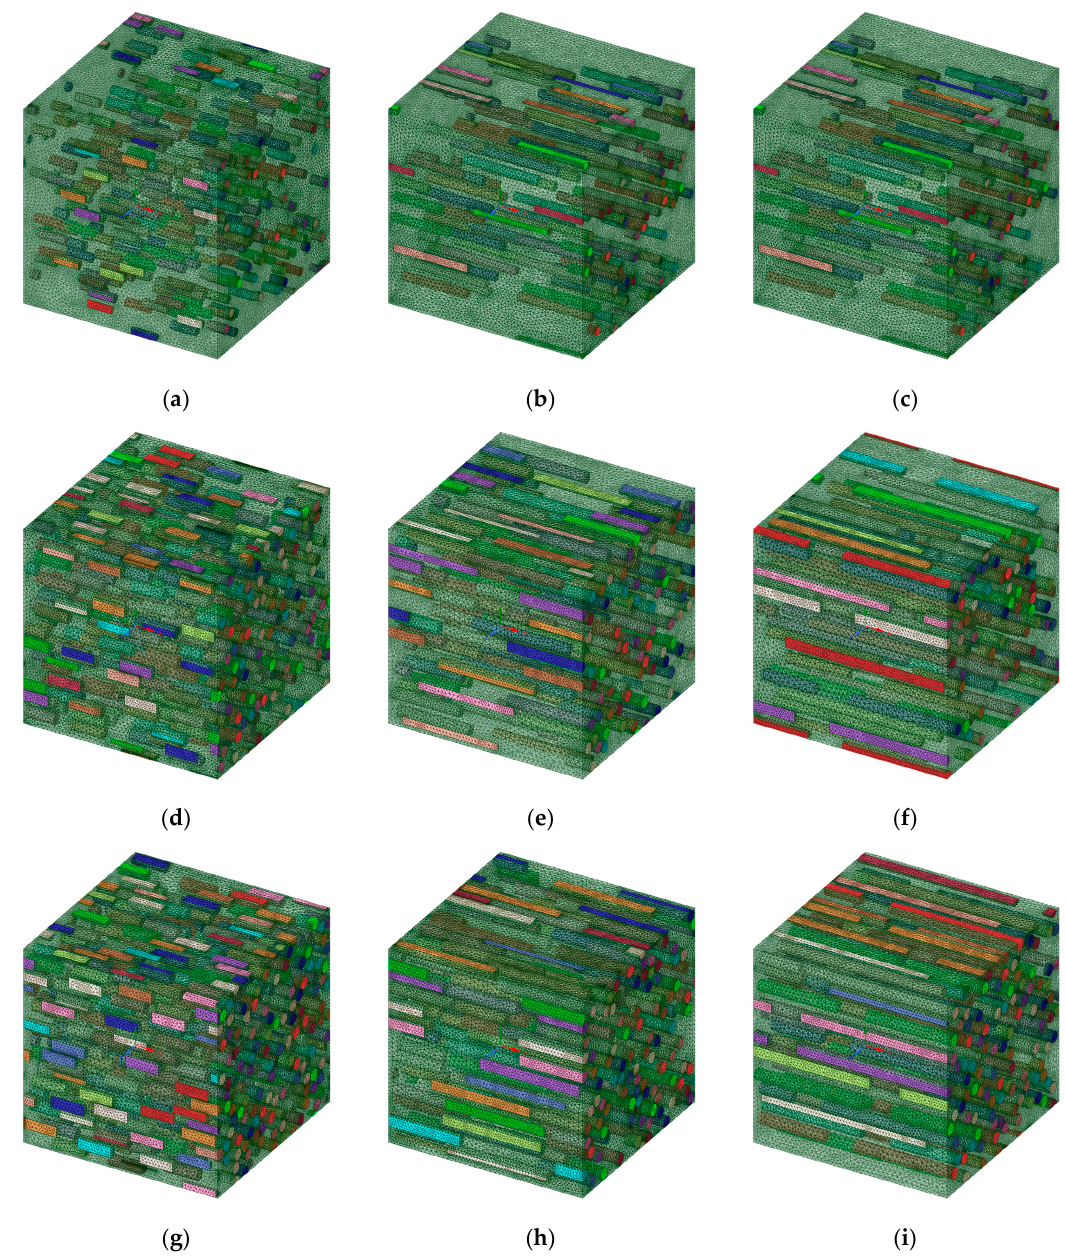
Figure 2. Composite material finite element analysis 3D model, ( a ) VF5%—Aspect ratio 3, ( b ) VF5%—Aspect ratio 9, ( c ) VF5%—Aspect ratio 15, ( d ) VF15%—Aspect ratio 3, ( e ) VF15%—Aspect ratio 9, ( f ) VF15%—Aspect ratio 15, ( g ) VF25%—Aspect ratio 3, ( h ) VF25%—Aspect ratio 9, ( i )